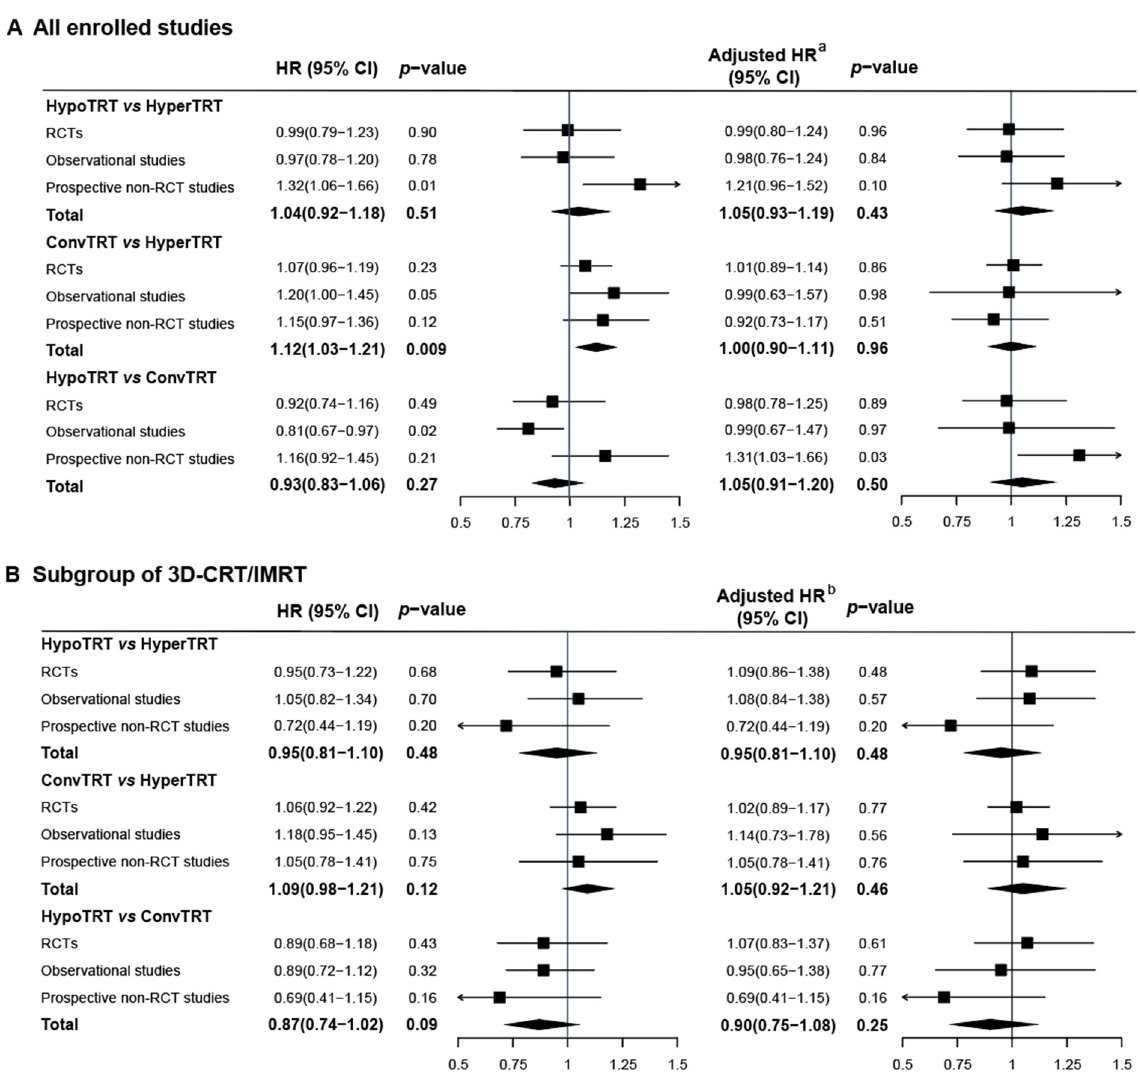
Figure 3. Forest plots showing the hazard ratio estimates based on the shared-frailty model. ( A ), For- est plot for all enrolled studies; ( B ), Forest plot for subgroup of 3D-CRT/IMRT. Abbreviations: HR, hazard ratio; CI, confidence interval; HypoTRT, hypofractionated thoracic radiotherapy; ConvTRT, conventional fractionated thoracic radiotherapy; HyperTRT, hyperfractionated thoracic radiother- apy; RCTs, randomized controlled studies; 3D-CRT, three-dimensional conformal radiotherapy; IMRT, intensity-modulated radiotherapy. a , b Adjusted for concurrent chemoradiotherapy, thoracic radiotherapy timing, and corrected biologically effective dose (all characteristics were regarded as binary variables).